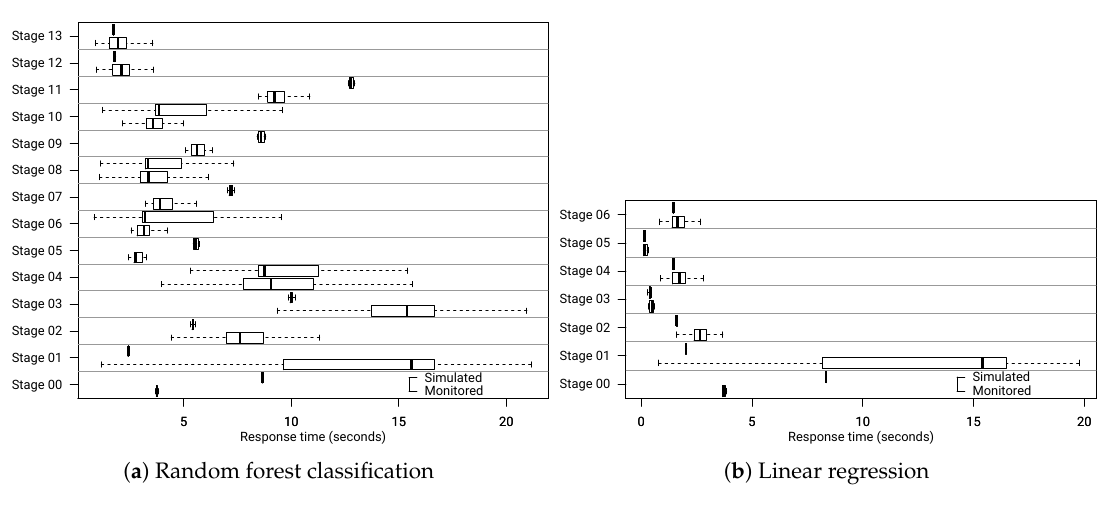
Figure 7. Response time statistics of Spark tasks for each stage (16 worker nodes, small data workload).